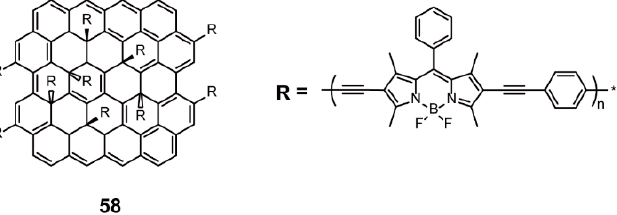
Figure 17. Chemical structures of polymer 58 (Reproduced with permission from Reference [87].